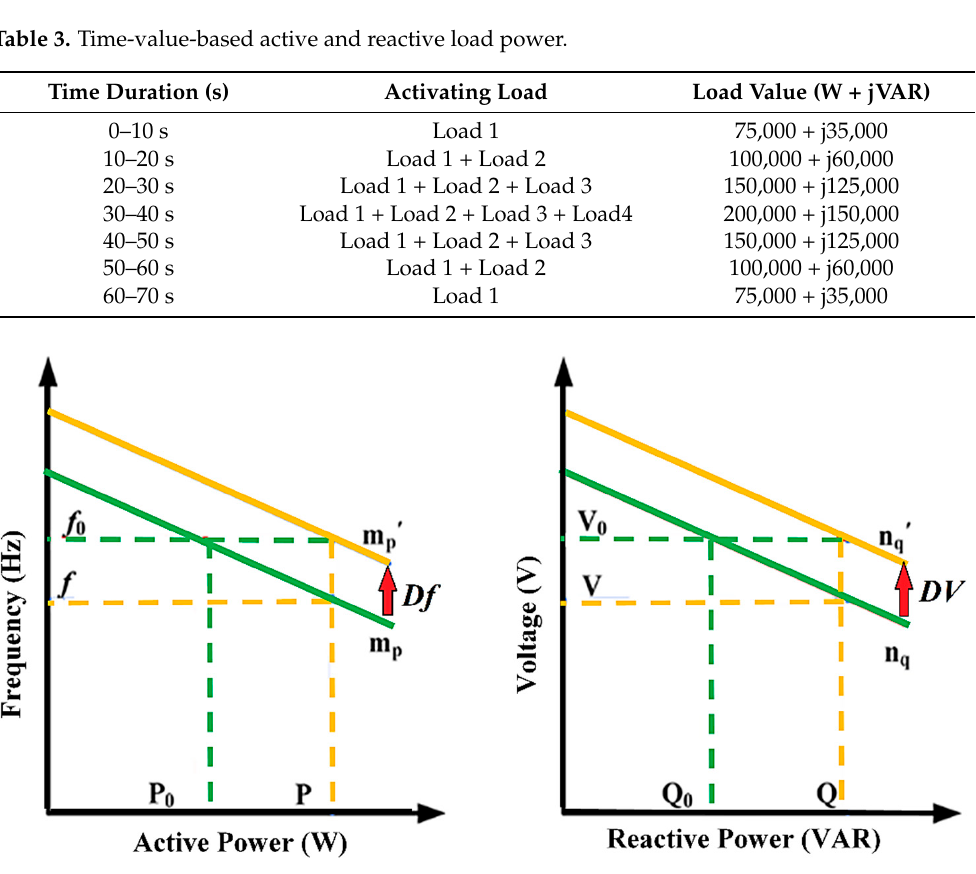
Figure 4. P/f and Q/V droop characteristics.